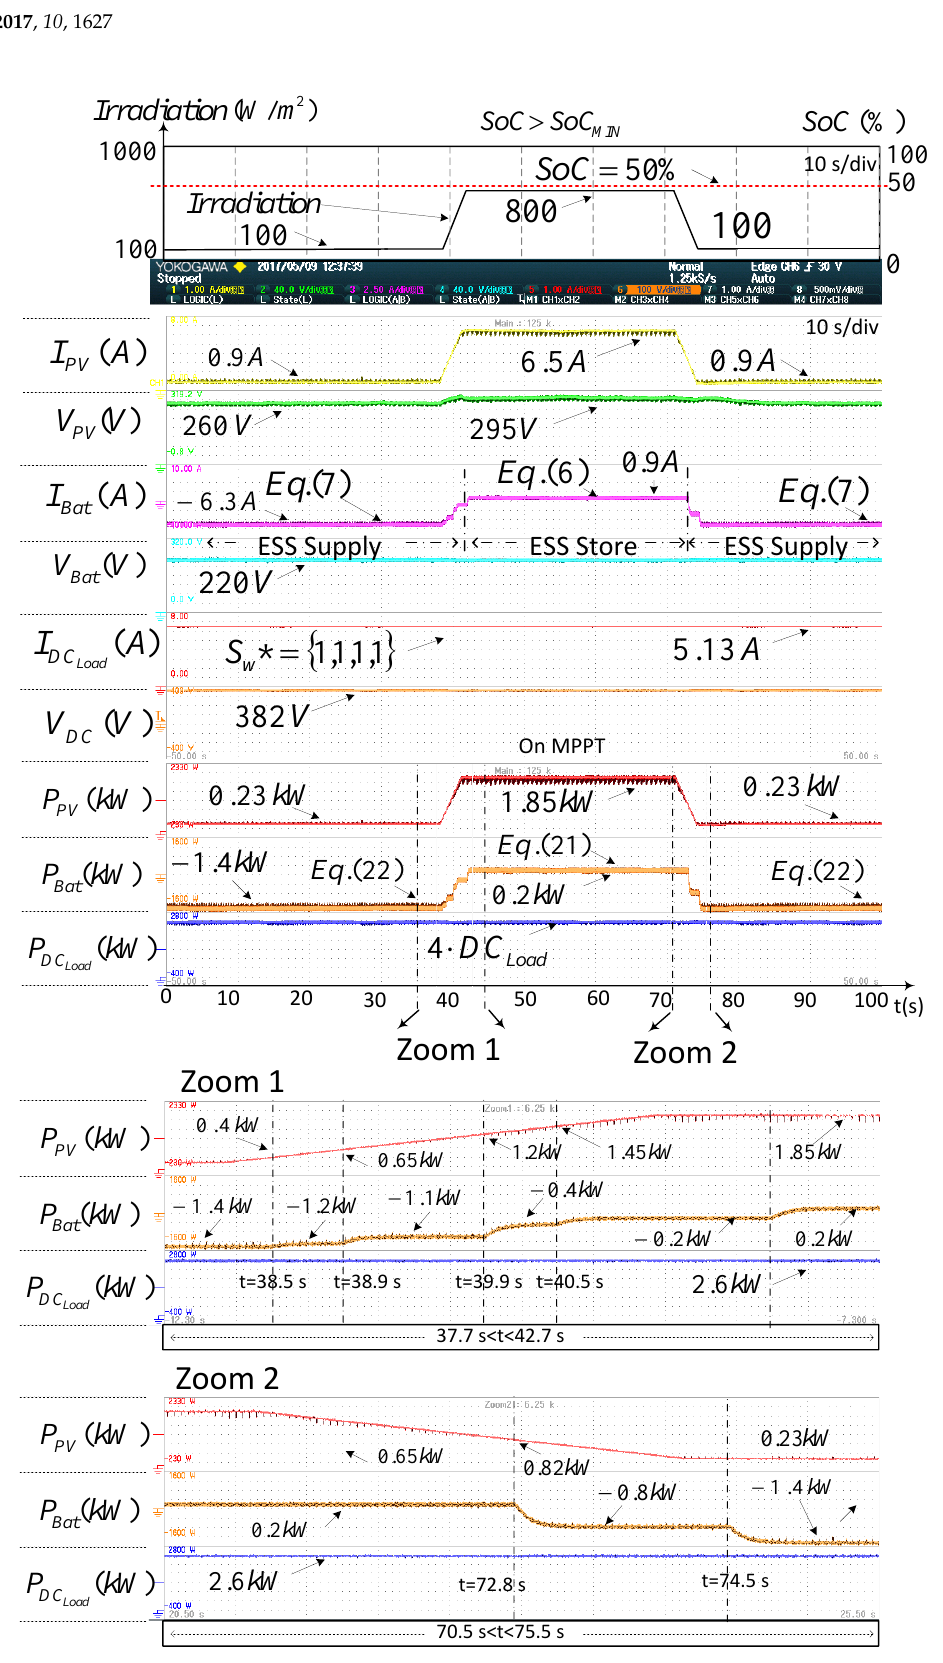
Figure 9. Experiment #1. Evolution of the currents, the power exchange and voltage in the DC microgrid for changes in the irradiation at a SoC > SoC MIN .